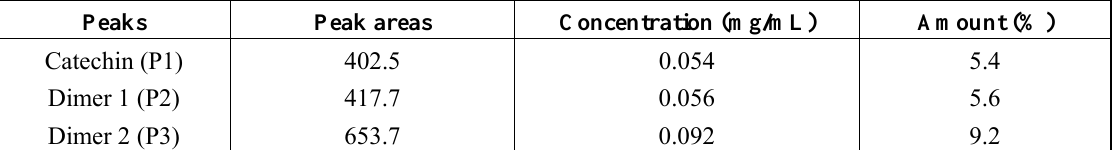
Table 2. Different amounts of purified compounds in C. perpulchrum